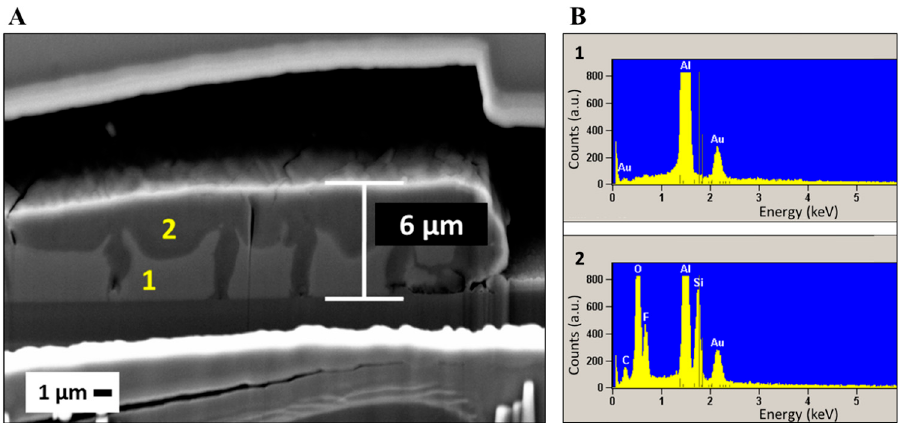
Figure 9. FIB cross-section of a degraded aluminum field plate for an HV-THB tested diode after 200 h of testing at 80% V nom ( a ). The capping layer (polyimide) was lifted, revealing a gap and the underlying metal field plate, showing 2 different phases ( b ). The change in composition was confirmed by energy-dispersive X-ray spectroscopy (EDX) analysis at 2 points, showing: (1) no degradation and (2) compositional and shape degradation. Figure reproduced with permission from [6].